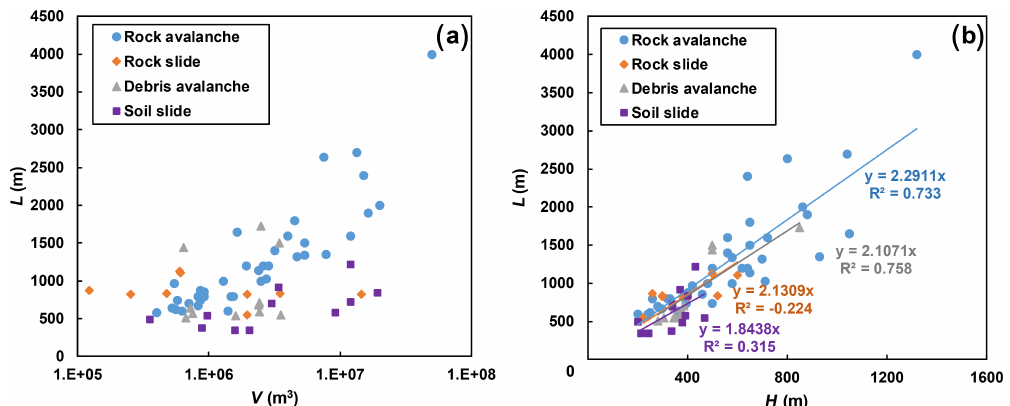
Figure 11. Relationship between the volume and travel distance (a) and between the total height and travel distance (b) of different-type landslides triggered by the Wenchuan earthquake (rockslide, debris avalanche and soil slide data are from Guo et al., 2014).